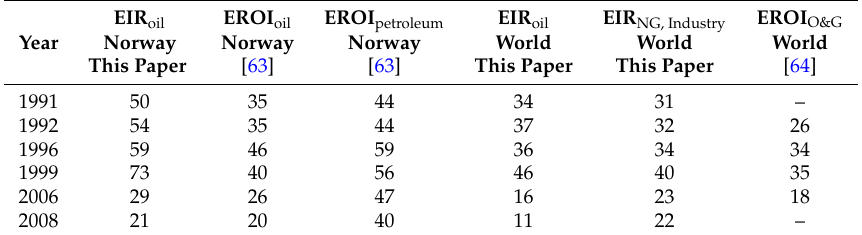
Table 2. Comparisons of EIR to EROI (= GEPR) calculations in the literature (selected years cited in references): Grandell et al. [63] for Norway oil and petroleum and Gagnon et al. [64] for the world oil and gas. EIR